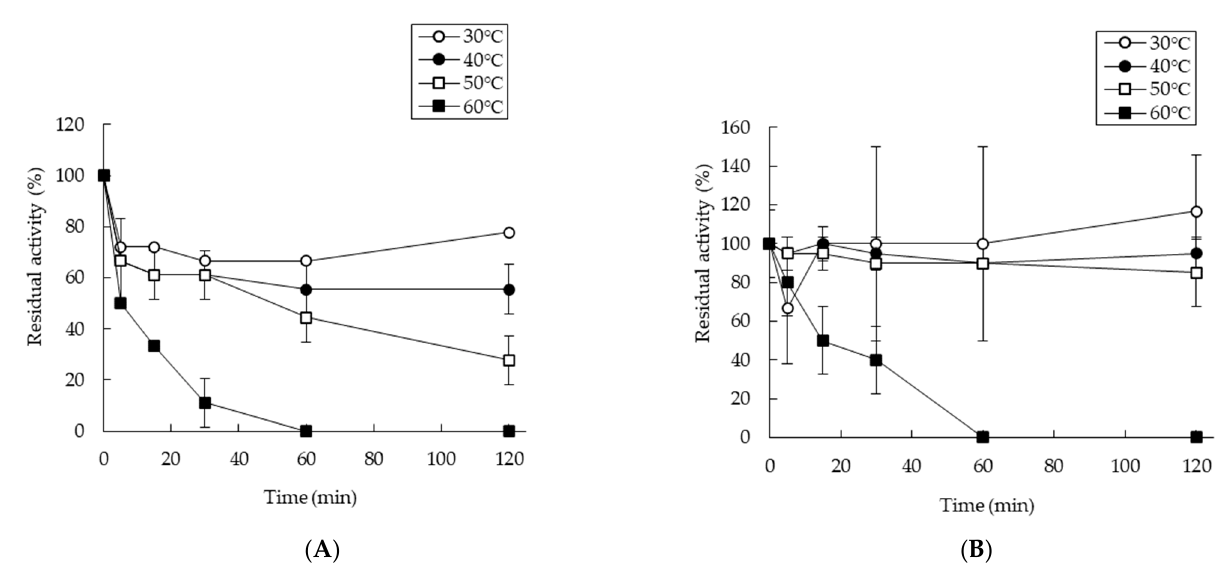
Figure 4. Thermostability of purified SaDyP1. SaDyP1 peroxidase activity toward ABTS ( A ) and DMP ( B ) at 30 °C after incubation at 30 °C, 40 °C, 50 °C or 60°C ( n = 3). Residual activity at 0 h was defined as 100%. Open circles, 30 °C; closed circles, 40 °C; open squares, 50 °C; closed squares, 60 °C.